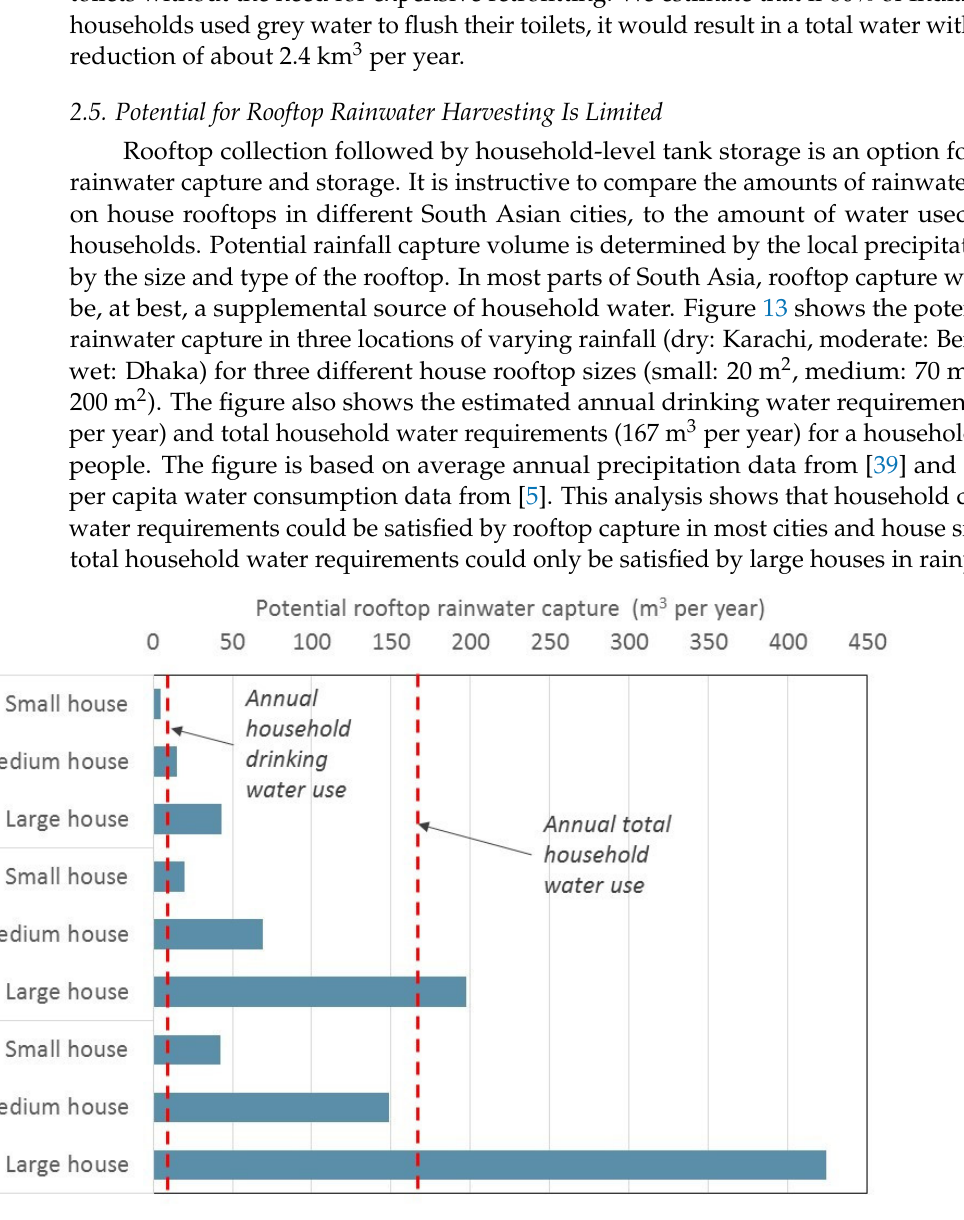
Figure 13. The amount of rainfall that may be captured by a household depends on the local annual precipitation and on the size of the rooftop capture area. Drinking water requirements could be satisfied by rooftop capture in most cities and house sizes, but total household water requirements could only be satisfied by larger houses in wetter cities.